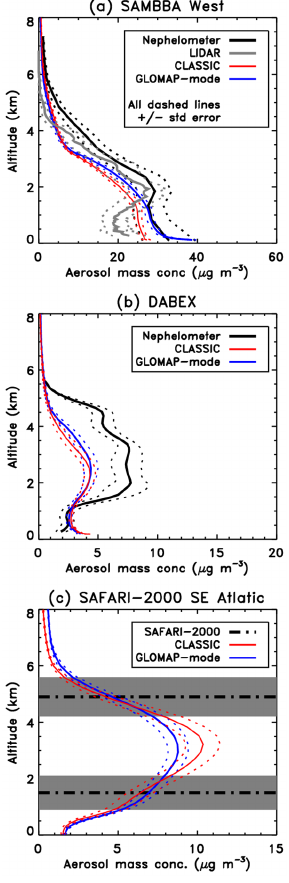
Figure 14. Vertical profiles of fine-mode aerosol mass concen- tration for the SAMBBA, DABEX, and SAFARI-2000 airborne campaigns, including model averages for CLASSIC (red) and GLOMAP-mode (blue). Dashed lines show the mean ± the stan- dard error. Profiles of mass concentrations have been estimated from campaign-averaged nephelometer (black) and lidar (green) obser- vations using the fine-mode specific scattering ( k sca,fm ) and ex- tinction coefficients ( k ext,fm ) , respectively, derived from the in situ aircraft observations (see the second half of Table 2; k sca,fm = k ext,fm × SSA). The SAFARI-2000 observations indicate the av- erage altitude of the BBA layer base and top (black dot-dashed line) ± the standard deviation (grey